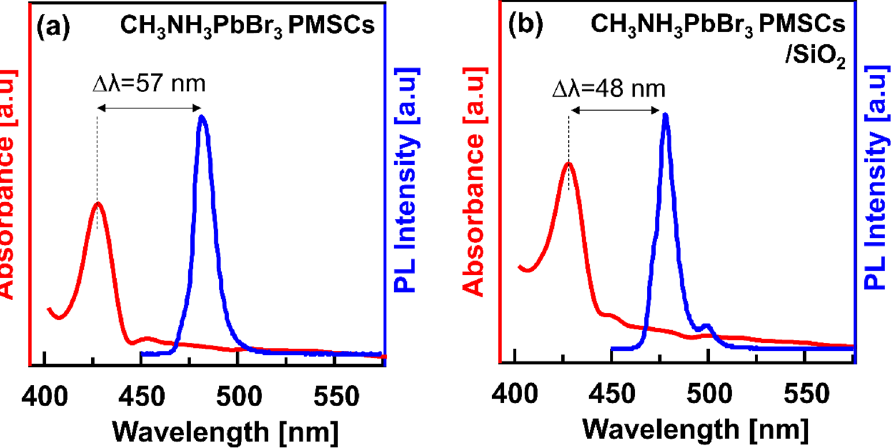
Figure 2. UV–Vis absorption and PL emission of the as-synthesized samples that synthesized at 6 °C. ( a )